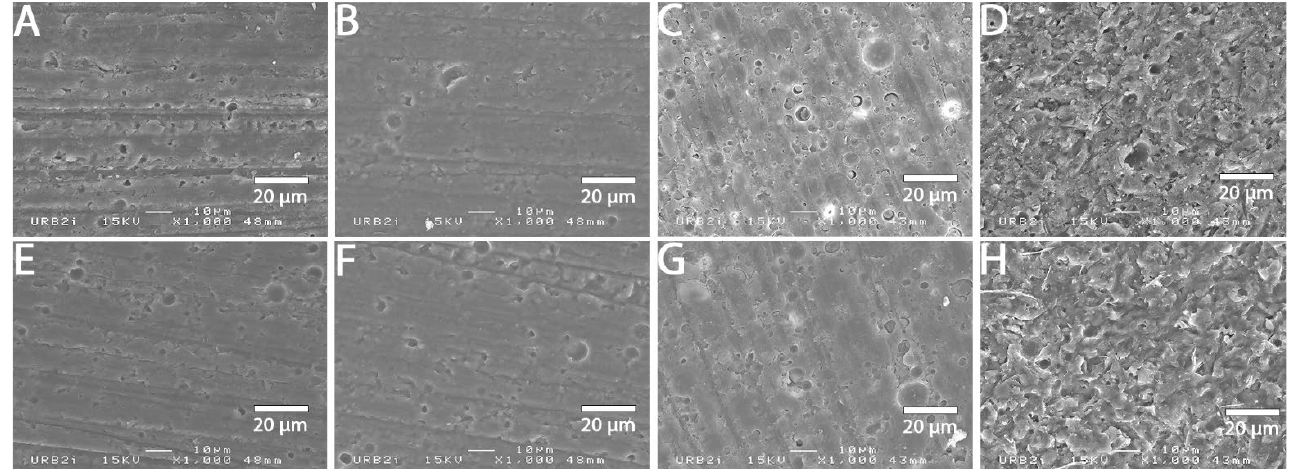
Figure 6. SEM micrograph for Shofu Block HC surface (×1000 magnification) with the different sur- face treatments: ( A ) control; ( B ) polyacrylic acid; ( C ) hydrofluoric acid; ( D ) sandblasting; ( E ) 800 grit polishing + universal primer; ( F ) polyacrylic acid + universal primer; ( G ) hydrofluoric acid + uni- versal primer; ( H ) sandblasting + universal primer. Sandblasting surface treatment ( D , H ) shows a more irregular pattern surface than the other ones.